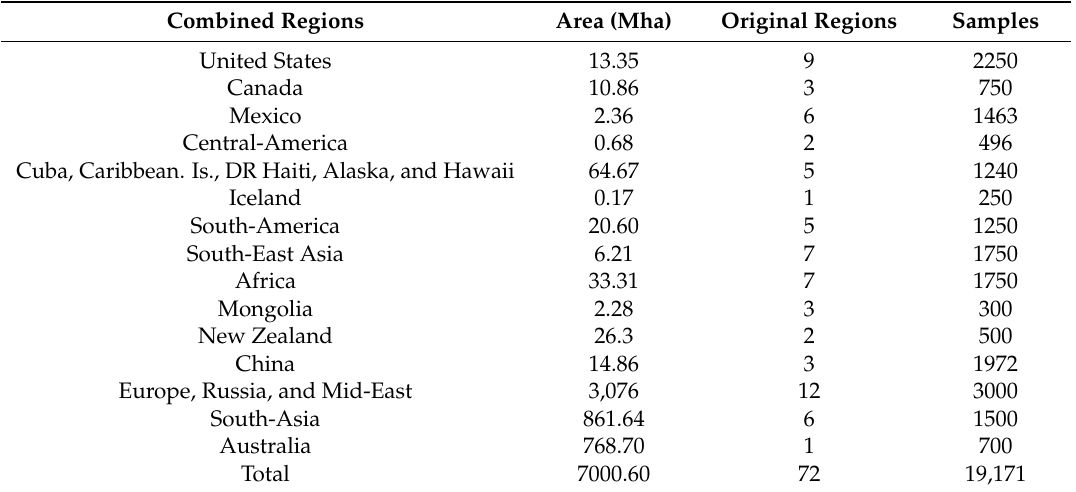
Table 11. Regions and number of reference samples used to assess the GFSAD30m cropland extent map. Combined Regions